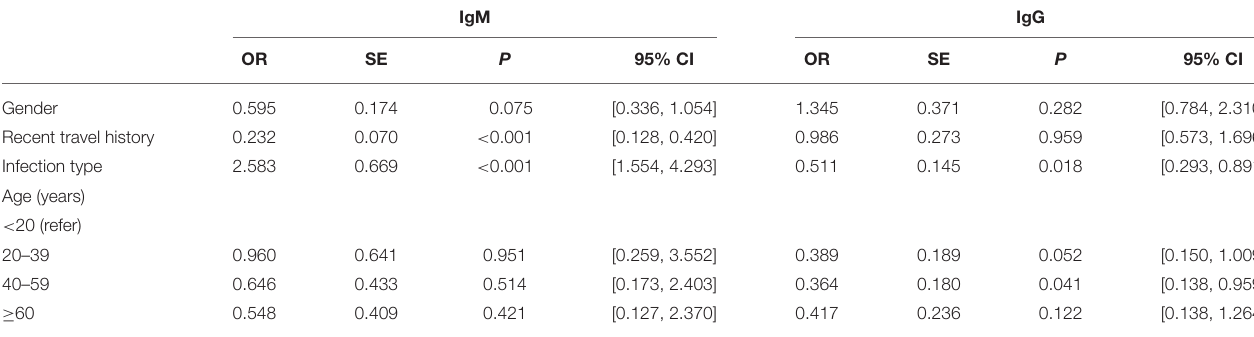
TABLE 3 | Multivariable logistic regression analysis for IgM and